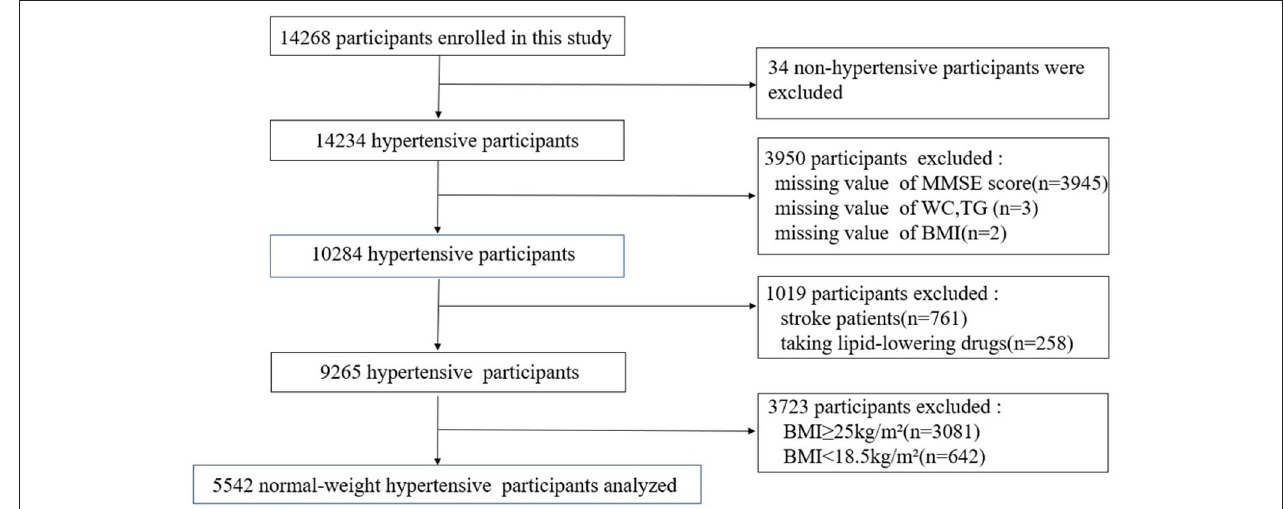
FIGURE 1 | Flow chart of the study participants.